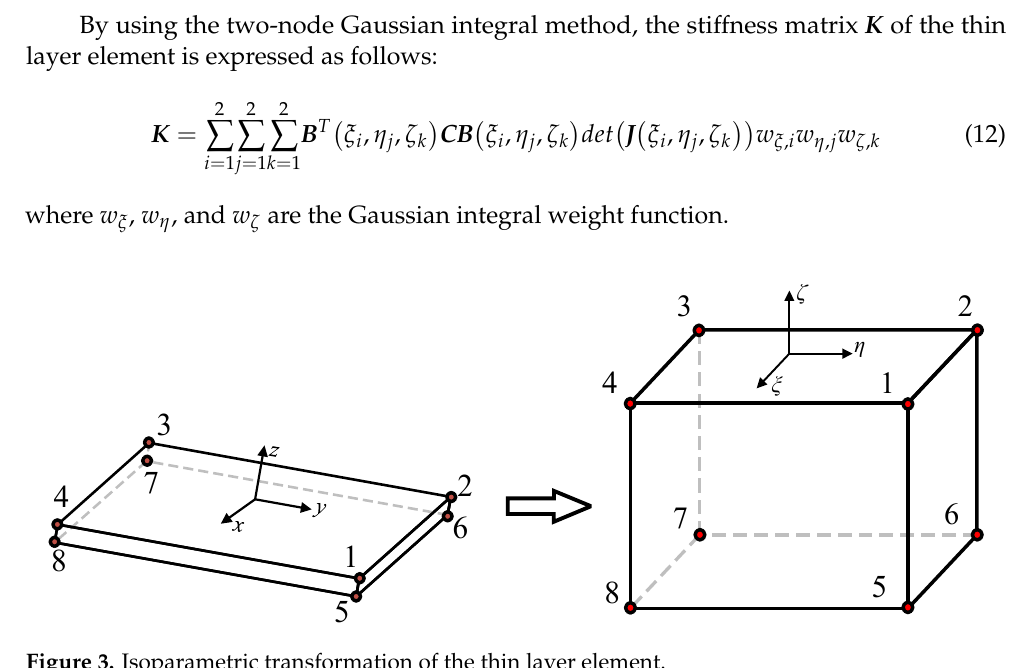
Figure 3. Isoparametric transformation of the thin layer element.